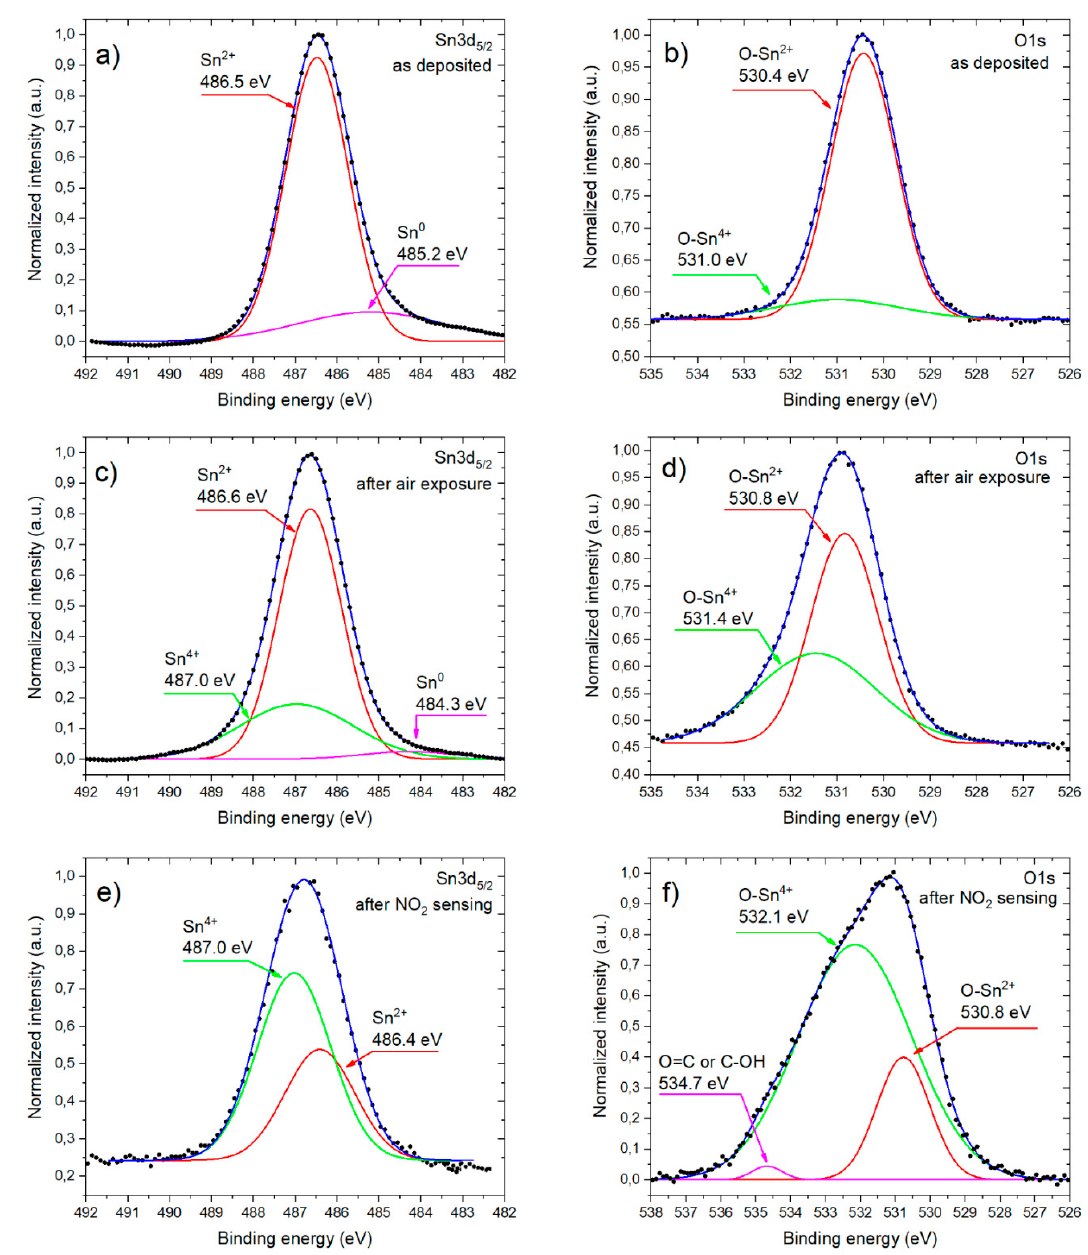
Figure 6. The decomposed O1s and Sn3d 5 / 2 core lines of RGVO SnO x nanolayer for the sample: as deposited ( a , b ); after air exposure ( c , d ); after NO 2 exposure ( e , f ).